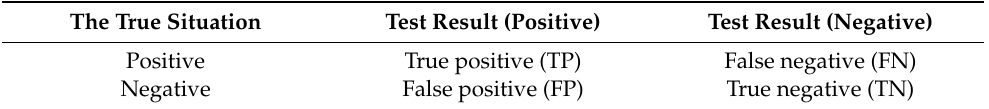
Table 9. Table of Table 9. Table of contingencies.